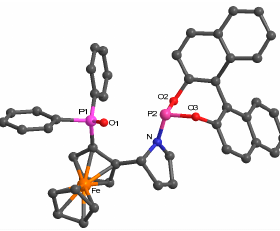
Figure 6. X-ray crystallographic analysis of L5 (15 % oxidation of P1 was observed).